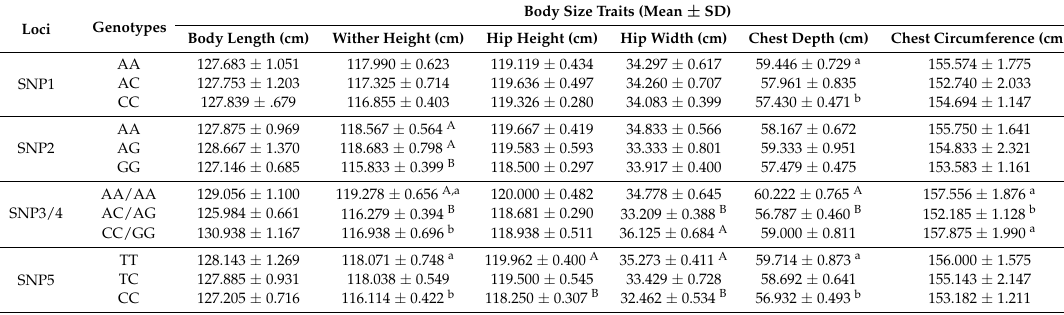
Table 5. Association of different SNP genotypes with body size traits in Qinchuan cattle.